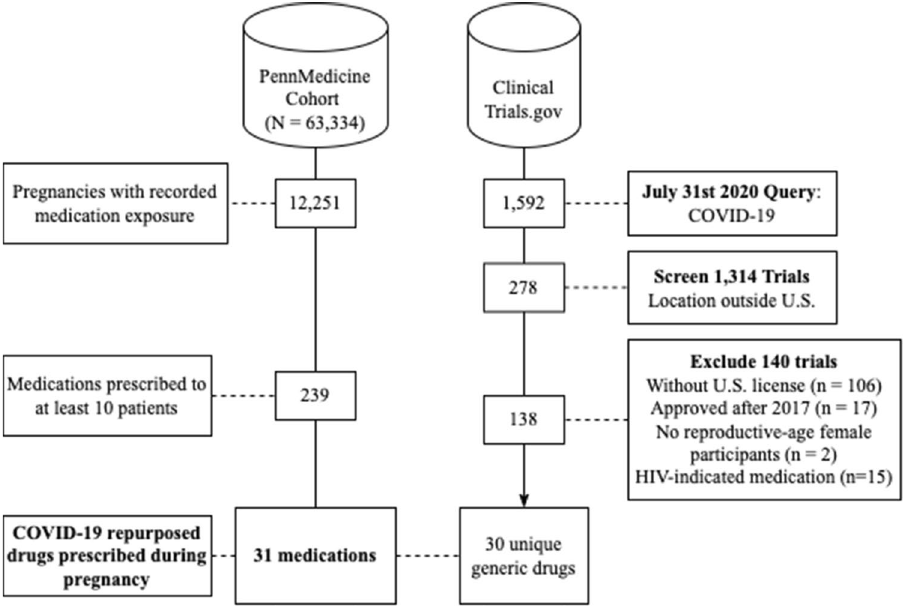
Figure 1. Flowchart of cohort and clinical trial selection